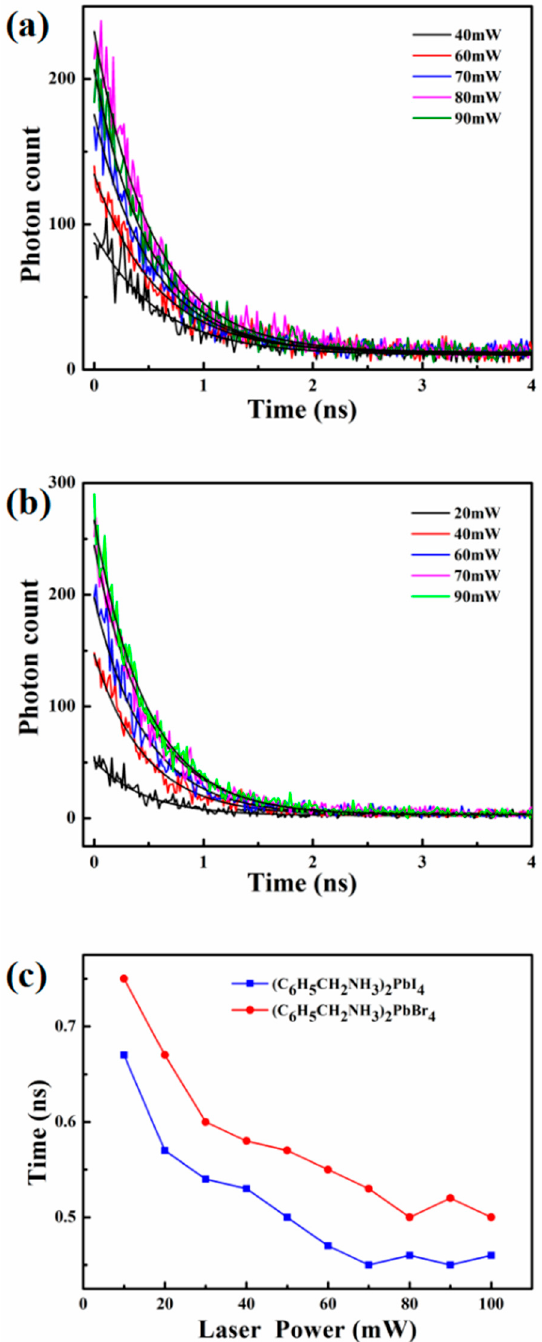
Figure 9. The PL lifetime of the perovskites ( a ) (C 6 H 5 CH 2 NH 3 ) 2 PbBr 4 ; ( b ) (C 6 H 5 CH 2 NH 3 ) 2 PbI 4 ; ( c ) laser power dependence of the PL lifetime of the perovskites (C 6 H 5 CH 2 NH 3 ) 2 PbBr 4 (red curve) and (C 6 H 5 CH 2 NH 3 ) 2 PbI 4 (blue curve).